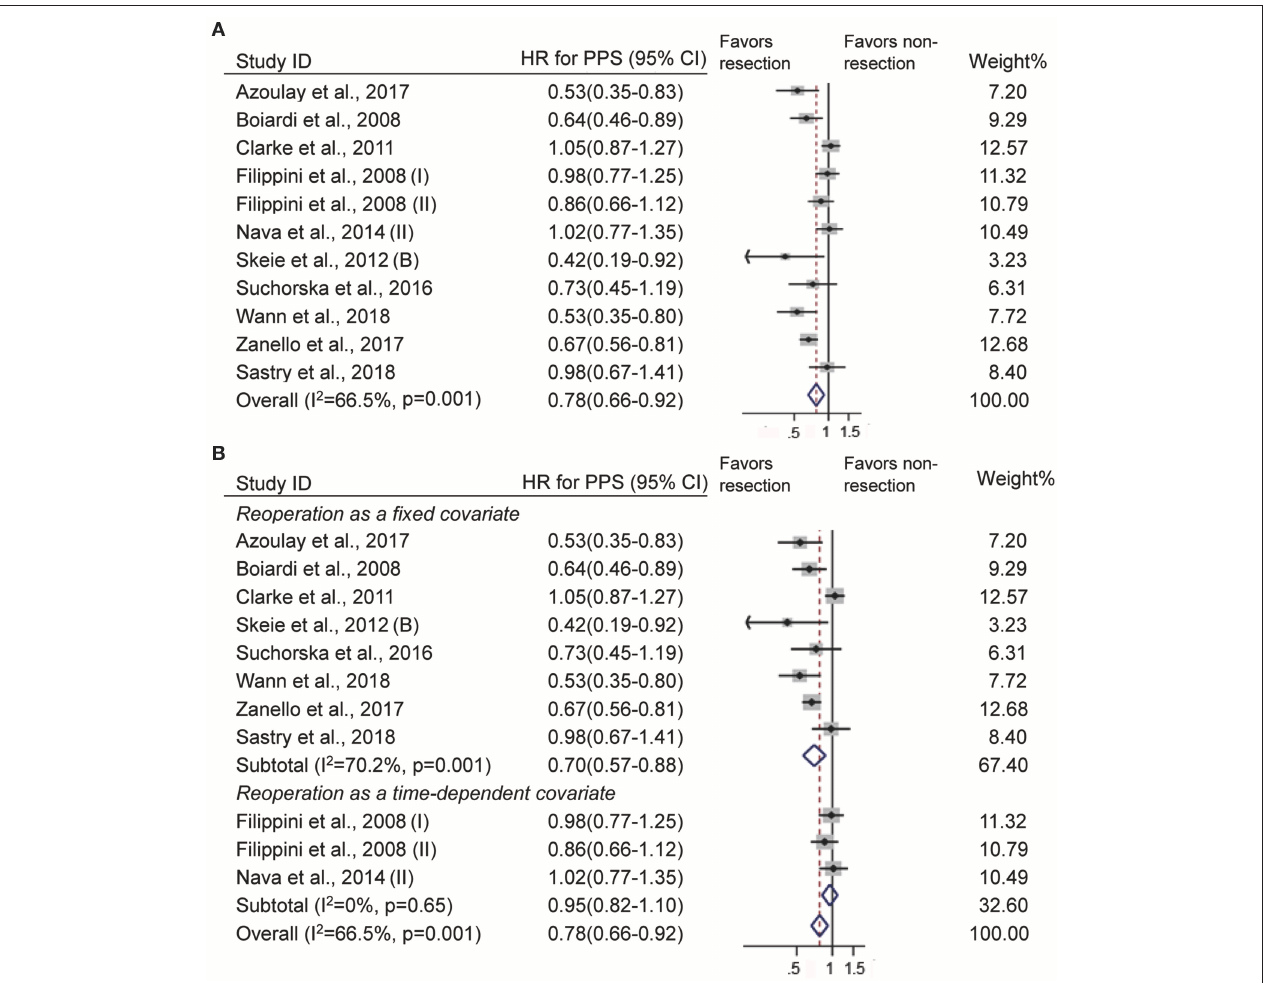
FIGURE 4 | Forest plots showing pooled results of post-progression survival analysis in patients with vs. without reoperation (A) and when reoperation was considered as a fixed covariate vs. as a time-dependent covariate (B)